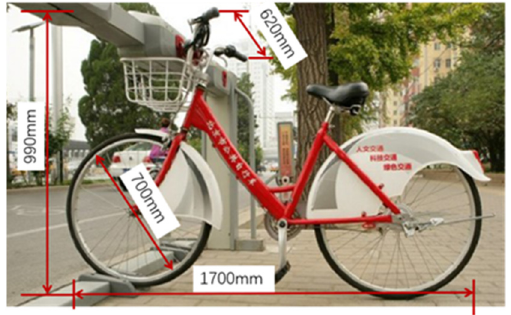
Figure 5. Dimensions of the typical bicycle.